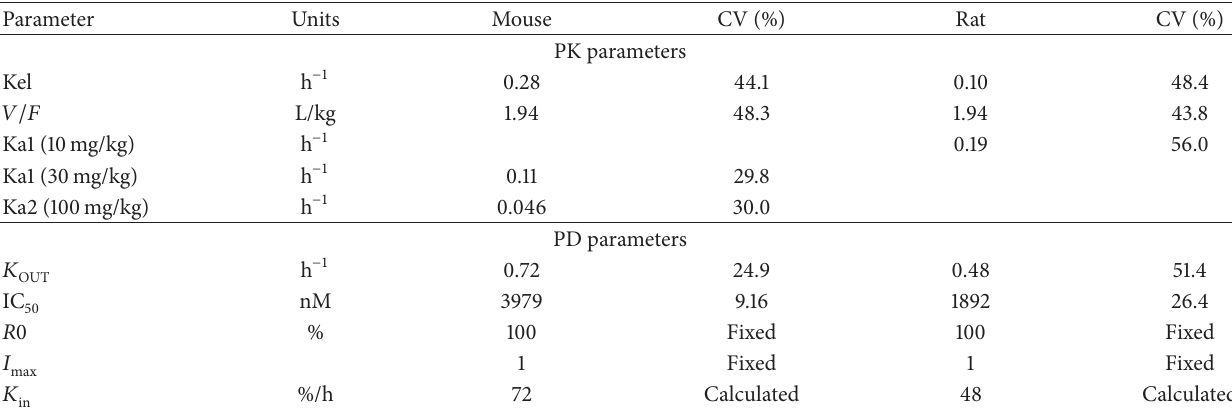
Table 2: PK/PD model values from mouse and rat studies.